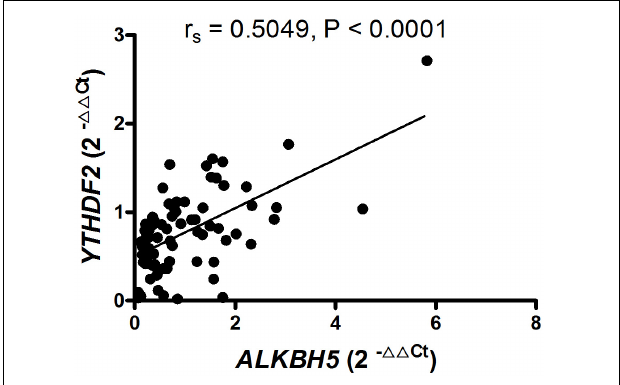
FIGURE 2 | RNA-binding proteins ( YTHDF2 ) positively correlated with demethylase ( ALKBH5 ) in patients with new-onset AS. ALKBH5, alkylation repair homolog protein 5; AS, ankylosing spondylitis; YTHDF2, YT521-B homology domains